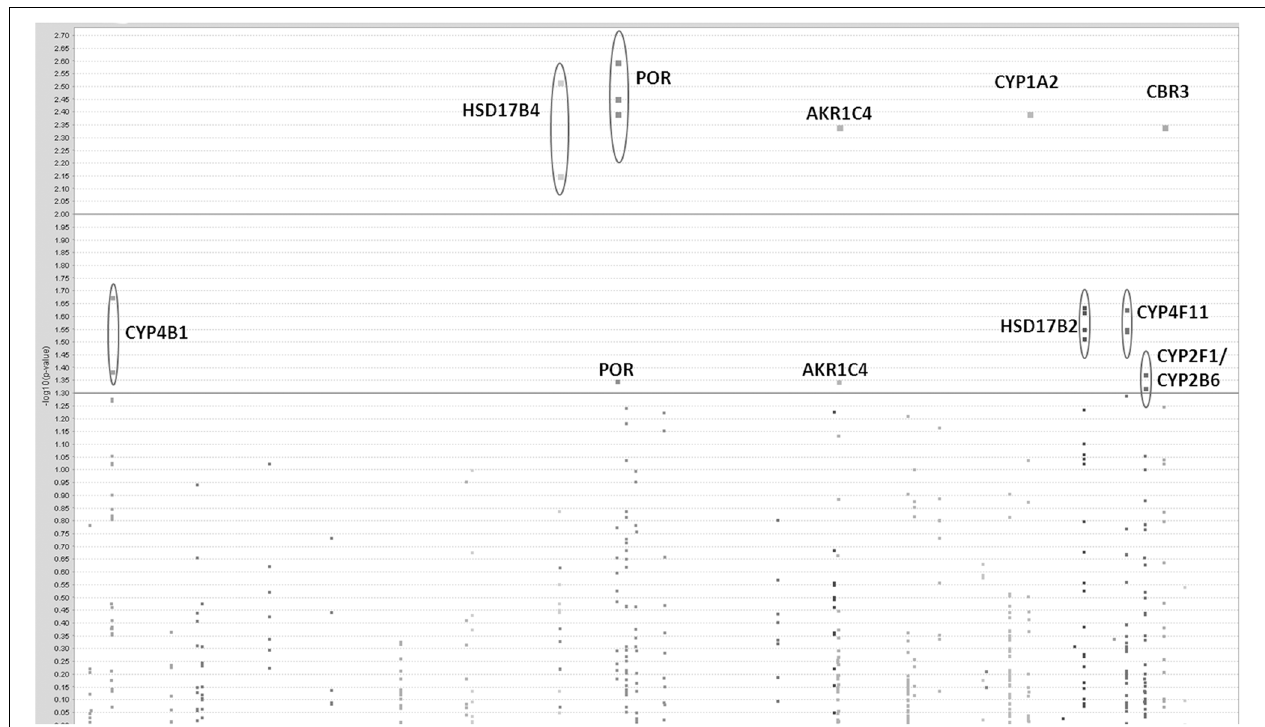
FIGURE 1 | Results of single-SNP based tests of association with drop in LVEF. A Manhattan plot of log transformed nominal p -values against SNP chromosomal